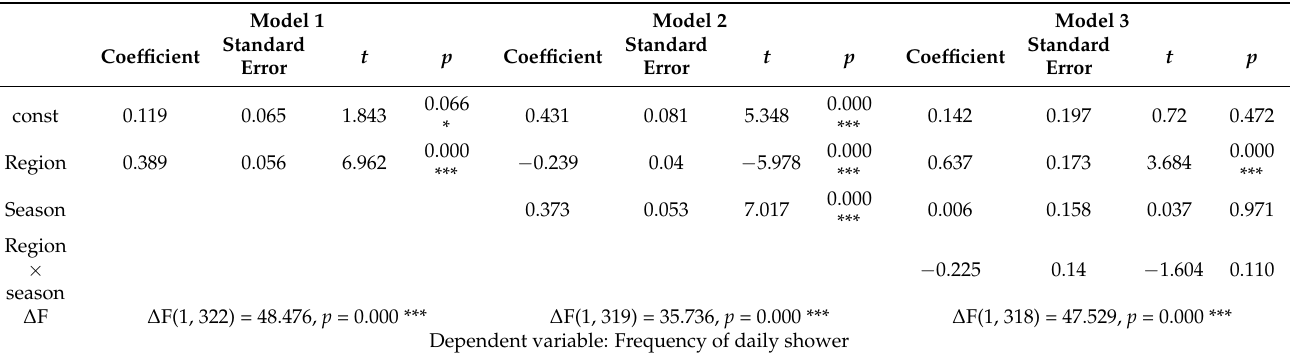
Table 5. Regulating effect analysis of factors in daily shower